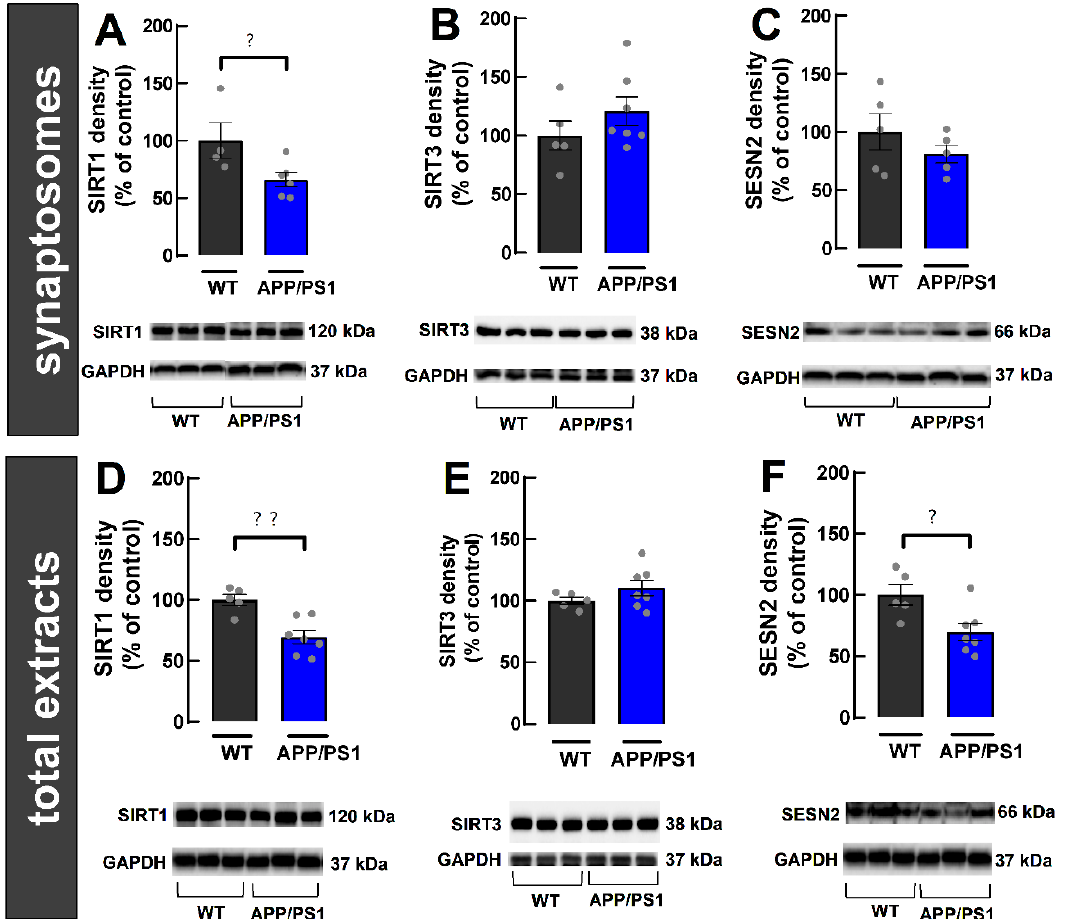
Figure 5. Alteration of the relative density of intracellular metabolic controllers in synapses ( A – C ) and outside synapses ( D – F ) in the cerebral cortex of 9-month-old female WT and APP/PS1 mice. ( A – C ) Cerebrocortical synaptosomes (purified synapses) from APP/PS1 mice displayed a decreased density of sirtuin 1 (SIRT1; ( A )), whereas there was no change in the density of sirtuin 3 (SIRT3; ( B )) or of sestrin 2 (SESN2; ( C )). ( D – F ) In total extracts (mostly extra-synaptic content) from APP/PS1 mice, there was a decreased density of SIRT1 ( D ) and of SESN2 ( F ), whereas there was no change in the density of SIRT3 ( E ). GAPDH (1:5000) was used as a loading control and results are presented as a ratio between the density of the protein of interest and GAPDH. Data are mean ± SEM of 4–7 experiments (number of different animals tested). ? p < 0.05 and ?? p < 0.01, using a Student’s unpaired t -test.